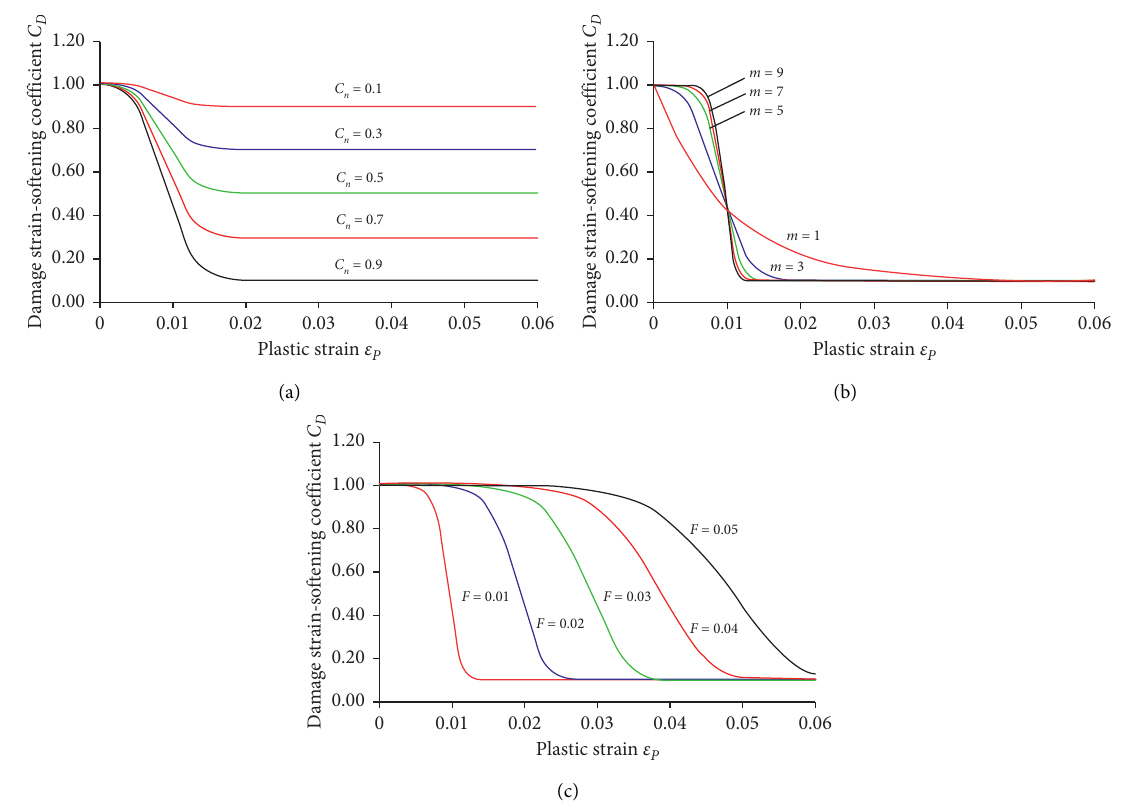
Figure 2: Variation of the damage strain-softening coefficient C (b) F � 0.01, C n � 0.9, and (c) m � 7, C n �